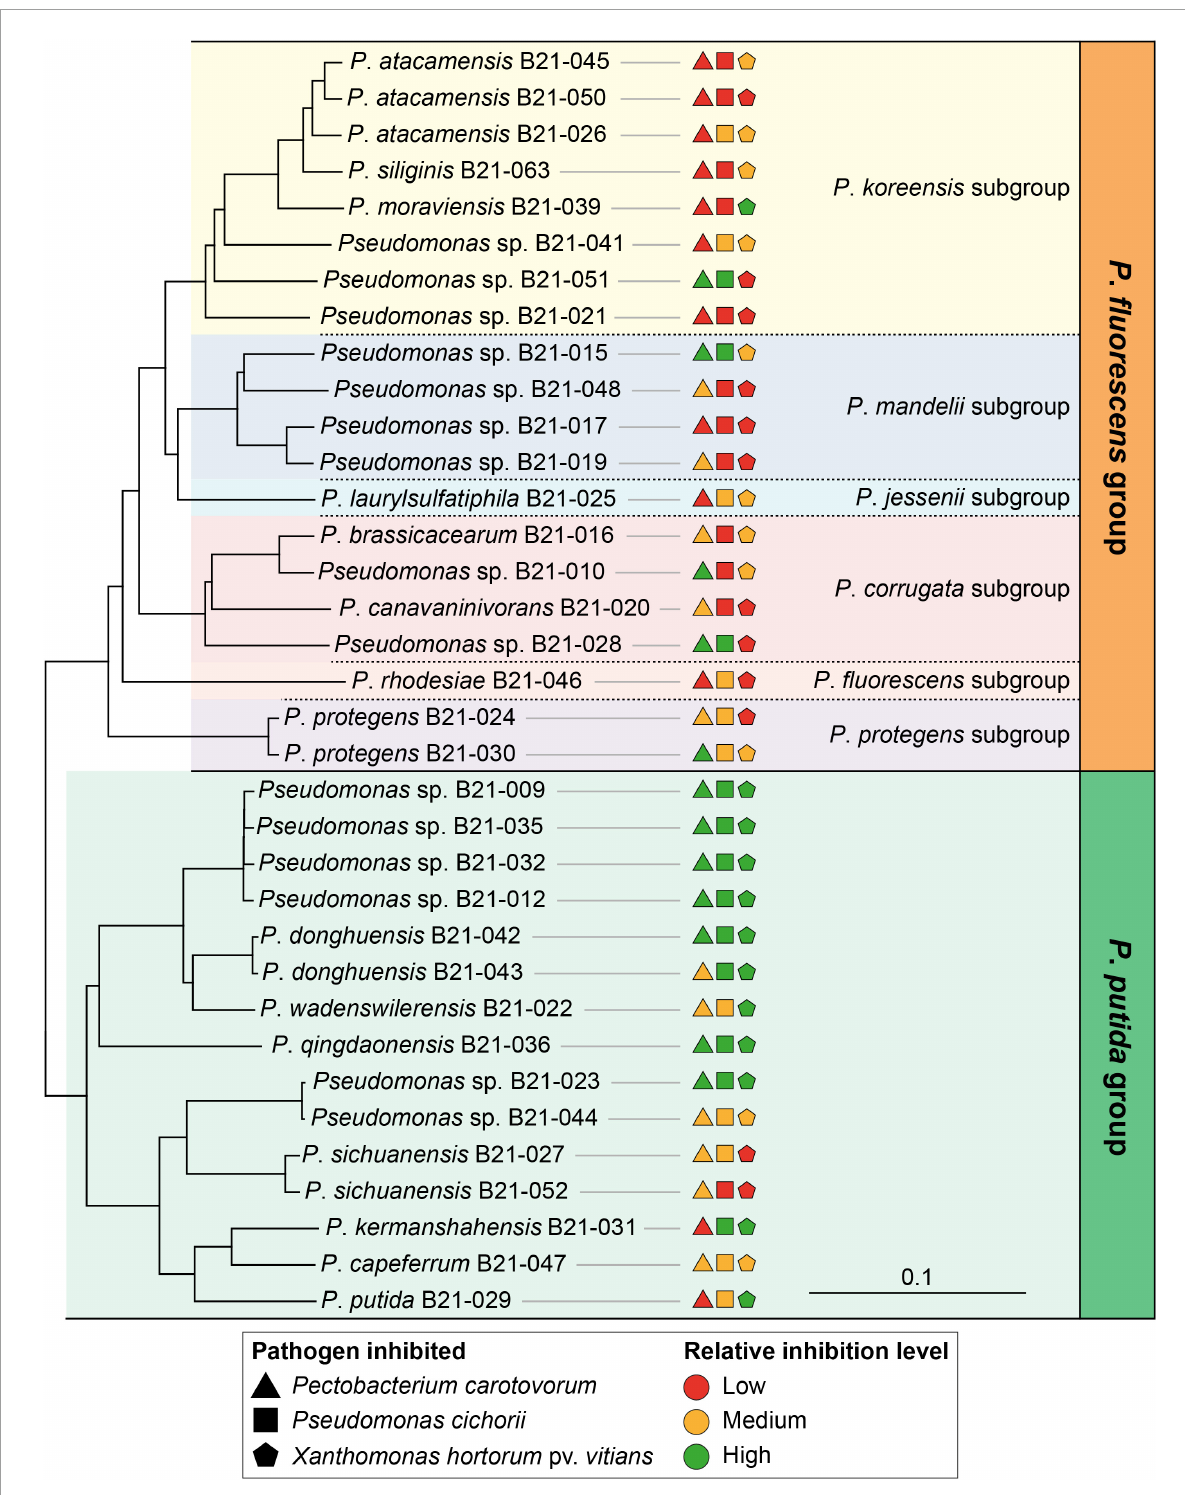
FIGURE2 Neighbor-joining phylogeny of the 35 isolated Pseudomonas strains and their relative inhibition levels against various lettuce bacterial pathogens. This phylogenomic tree was generated with EDGAR from a concatenated alignment of 2,215 shared genes per genome. P . aeruginosa DSM 50071 T was used as an outgroup (not shown on the tree). The colored inhibition levels refer to the levels presented in Figure 1 . All branches in the tree show 100% bootstrap support (500